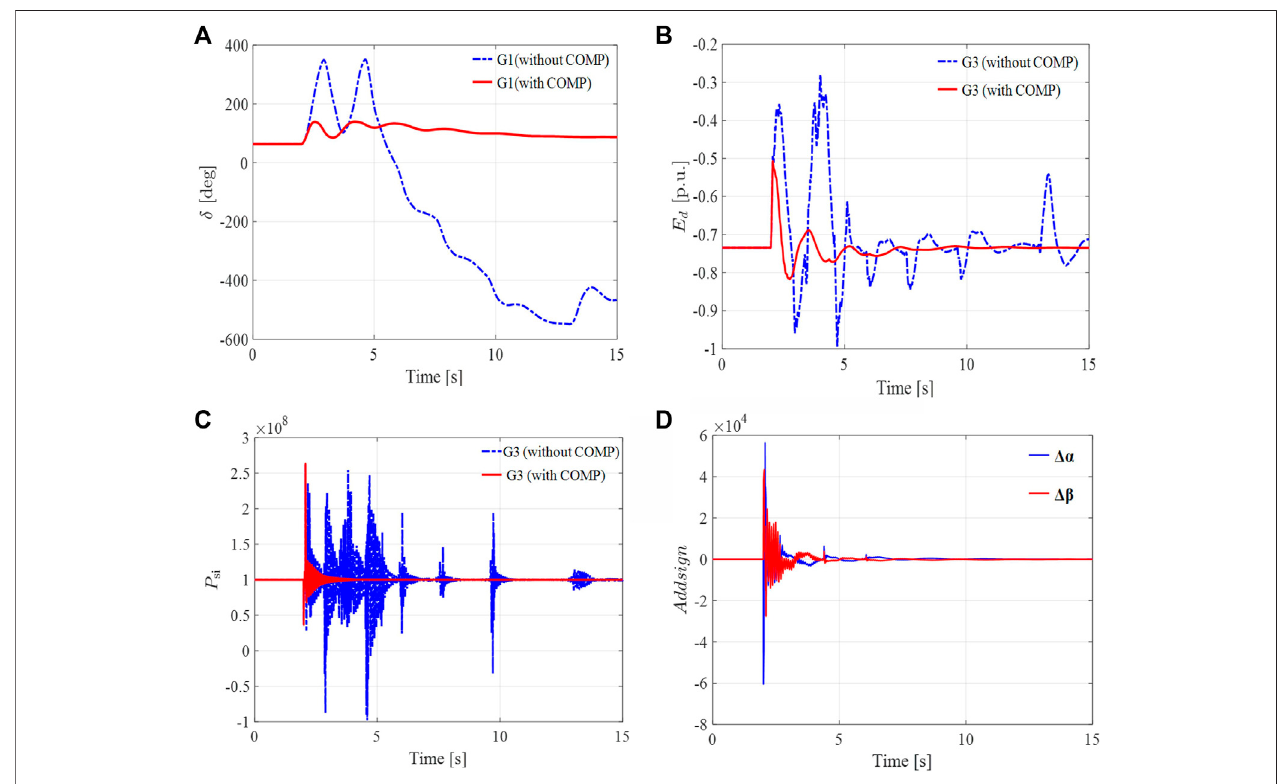
FIGURE12| DynamicresponsesofthegeneratorandtheMMC – MTDCandcompensationsignalofasingleMMCcontrolleraftercommunicationdelayoccurs. (A) The rotor angle of generator 3 in degrees. (B) d-axis component of the voltage 3 behind transient reactance in p.u. (C) Active power of MMC2. (D) The compensation signal acts on MMC2